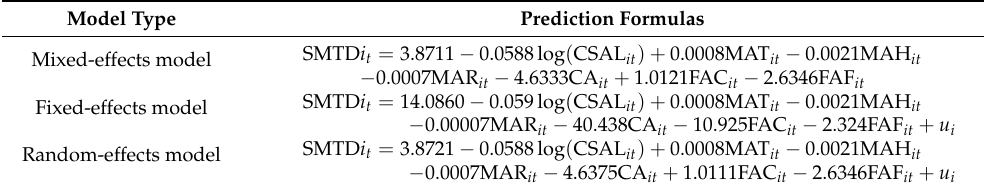
Table 5. Prediction formulas of surface texture model using the first 3 years SMTD panel